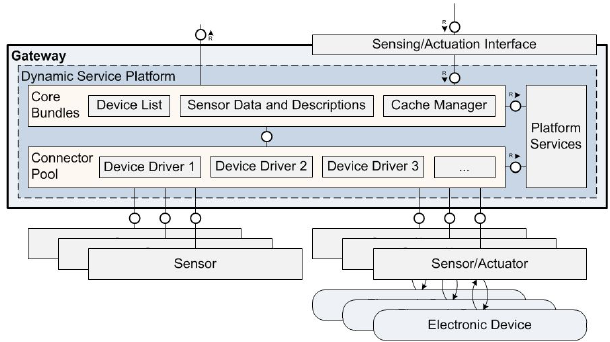
Figure 2: Gateway